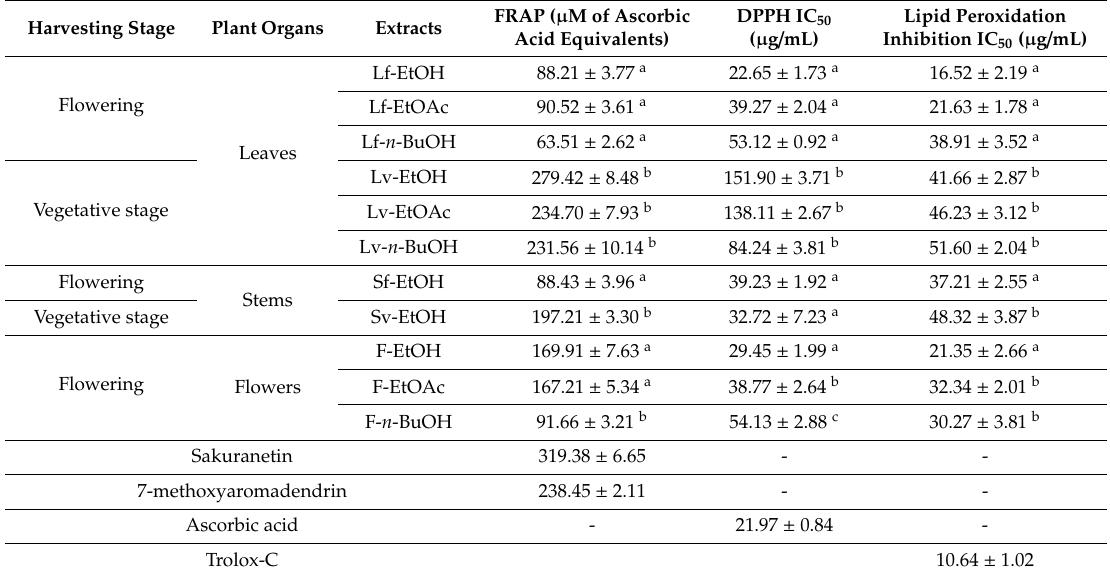
Table 2. In vitro antioxidant capacity of Ageratina havanensis (Kunth) R. M. King & H. Robinson extracts.